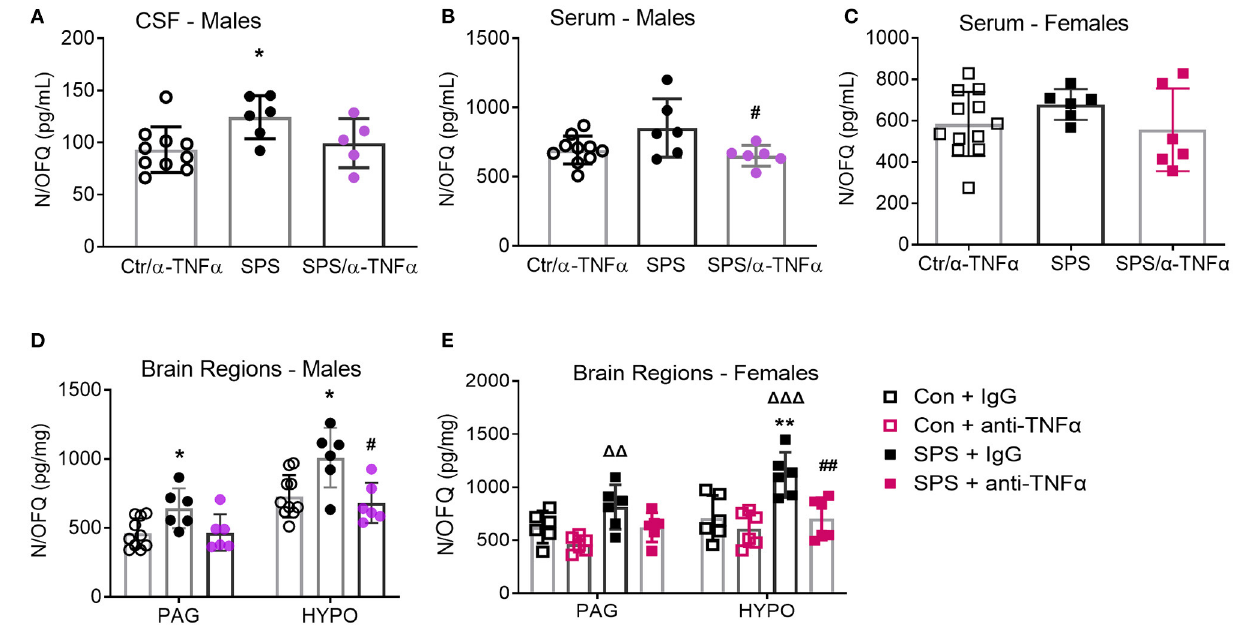
FIGURE 10 | Anti-TNF- α antibody treatment prevents SPS-induced increases in N/OFQ levels in males and females. Data from sham controls receiving IgG and sham controls receiving anti-TNF α antibody injections were combined and compared to SPS + IgG and SPS + anti-TNF- α antibody groups collected on day 9 post-SPS as scatter plots showing mean ± 95% CI. One SPS + anti-TNF antibody rat sample was excluded by Rout (A) . SPS treatment increased N/OFQ levels in CSF (A) , periaqueductal gray (PAG: D ) and hypothalamus (HYPO: D ) in male rats, * p < 0.05 as determined by one-way ANOVA compared to sham-treated rats. Antibody treatment prevented N/OFQ increases in the HYPO ( # p < 0.05). Though N/OFQ levels were not elevated by SPS in serum (B) , N/OFQ levels were significantly lower in serum from SPS + α -TNF- α antibody treated rats than from SPS rats ( # p < 0.05). There were no significant differences of serum N/OFQ between groups in females (C) . However, SPS-induced increases in female PAG and HYP ( 11 p < 0.01 and 111 p < 0.001 from Con+anti-TNF α ), and anti-TNF α antibody treatment reversal of increased N/OFQ in HYP ( ## p < 0.01 compared to SPS) (E) were the same as those in males (D)